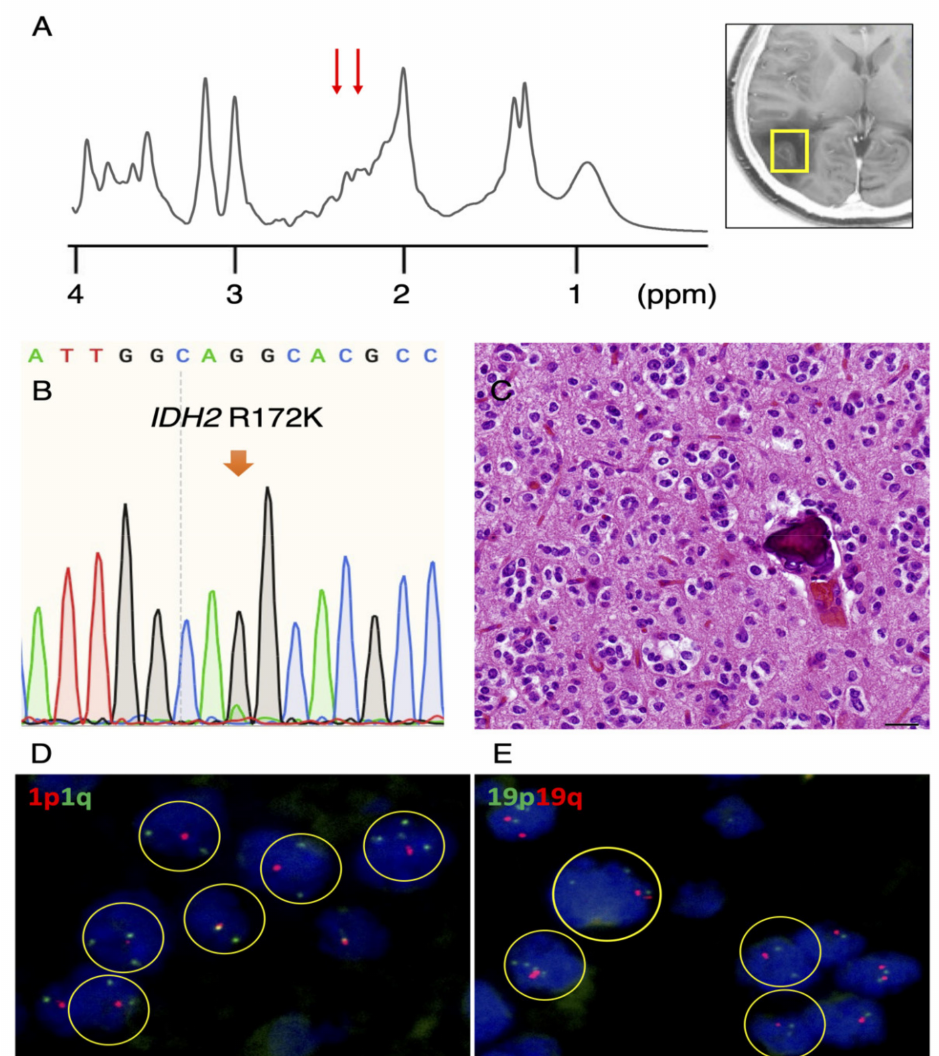
Figure 2. IDH2 mutation identified in a second case. ( A ) SVMRS spectra show minimal peaks at 2.25 ppm (red arrows) and 2HG quantified to be 2.763 mM. ( B ) A small, IDH2 R172K-mutant peak was detected. ( C ) Morphologically, tumor cells with perinuclear halos lacking astrocytic pro- cesses, chicken-wire vessels and calcification were observed, suggestive of oligodendroglioma (scale bar = 20 µ m). Codeletion of 1p ( D ) and 19q ( E ) were detected by fluorescence in situ hybridiza- tion